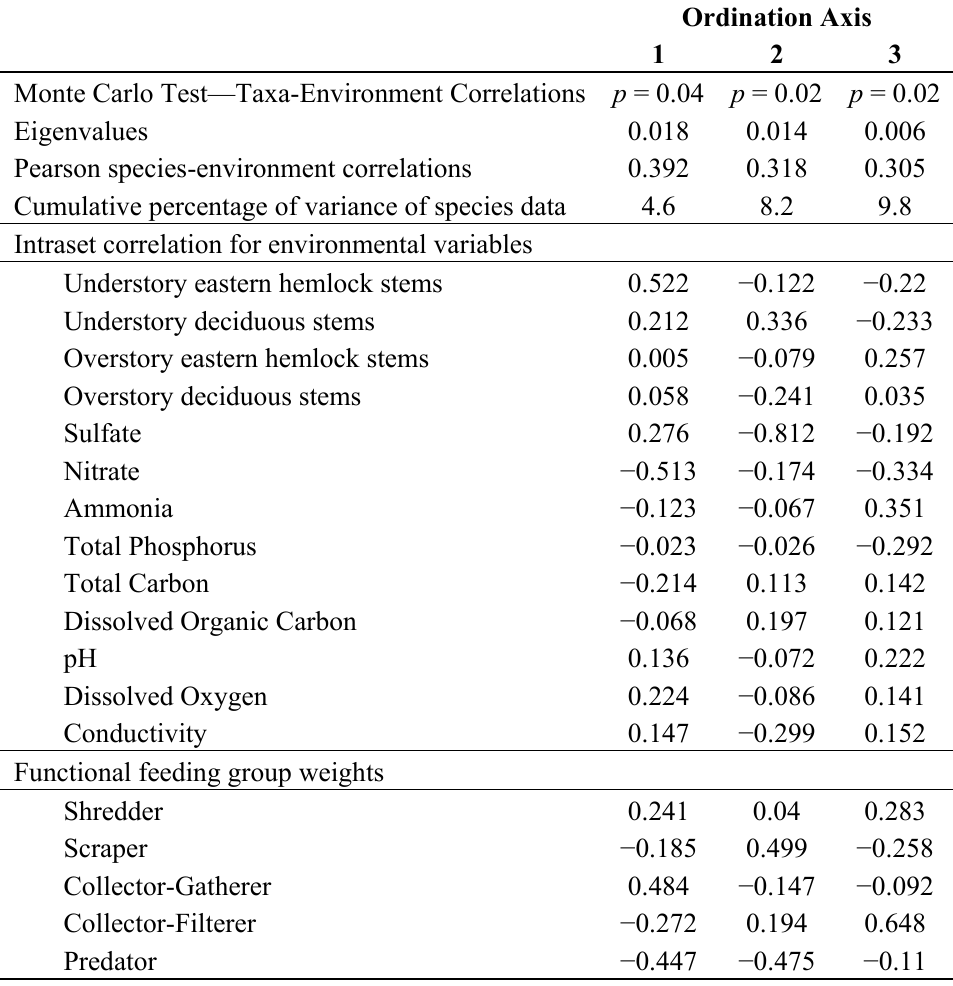
Table 3. Canonical correspondence analysis of benthic invertebrates collected via kick net and environmental parameters from streams dominated by eastern hemlock and deciduous riparian